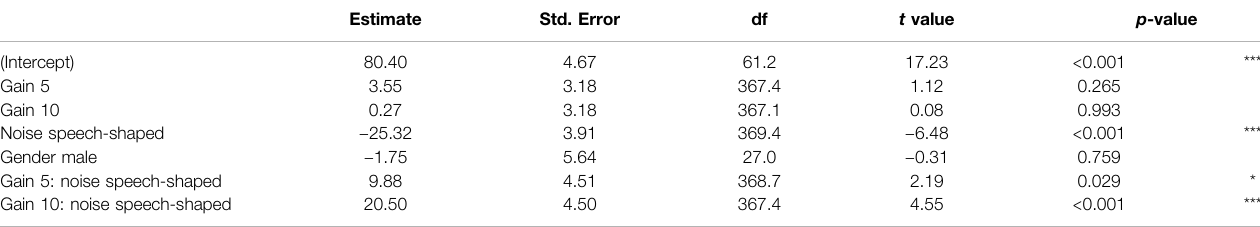
TABLE 4 | LME models fi t by REML for the response variable self-reported comfort and the fi xed factors 1) gain, 2) noise, 3) gender, and 4) the interaction between gain and noise. Estimate